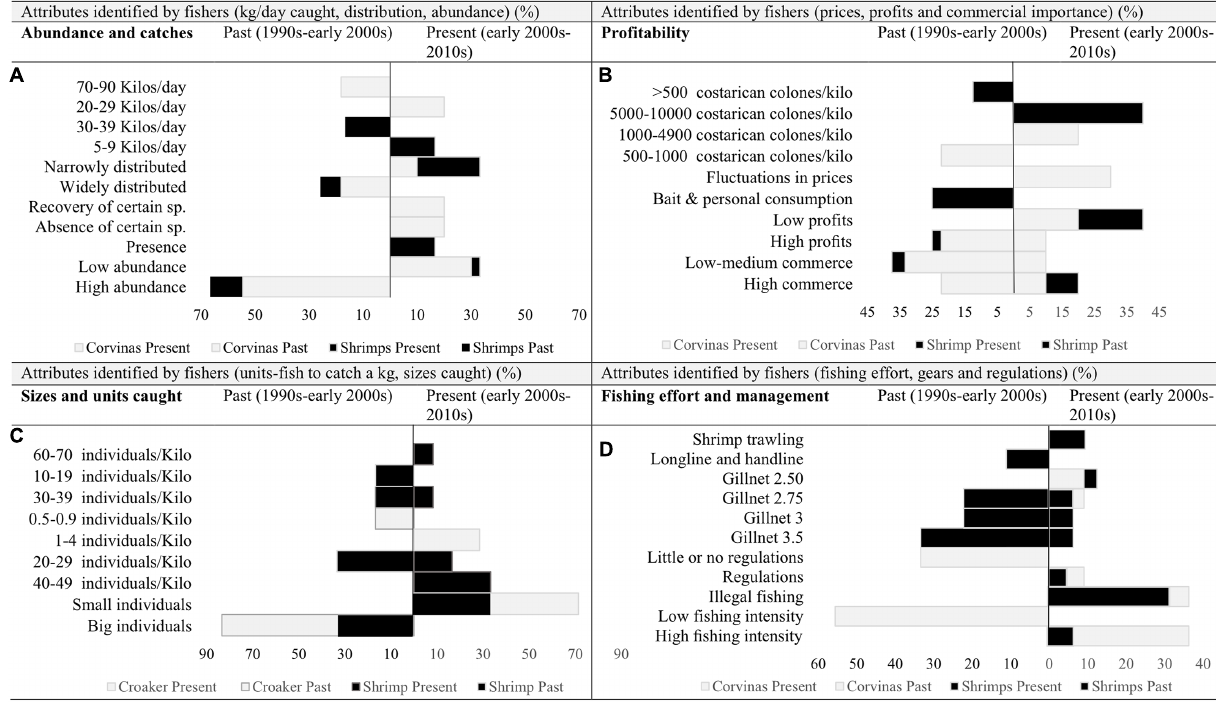
FIGURE 2 | Predominant topics and attributes identified in the focus groups related to the state of shrimps and corvinas [1990s and (or) 2000s]. Percentage of responses (%). Topics: (A) abundance/catches, (B) profitability, (C) sizes, and (D) fishing effort/management.